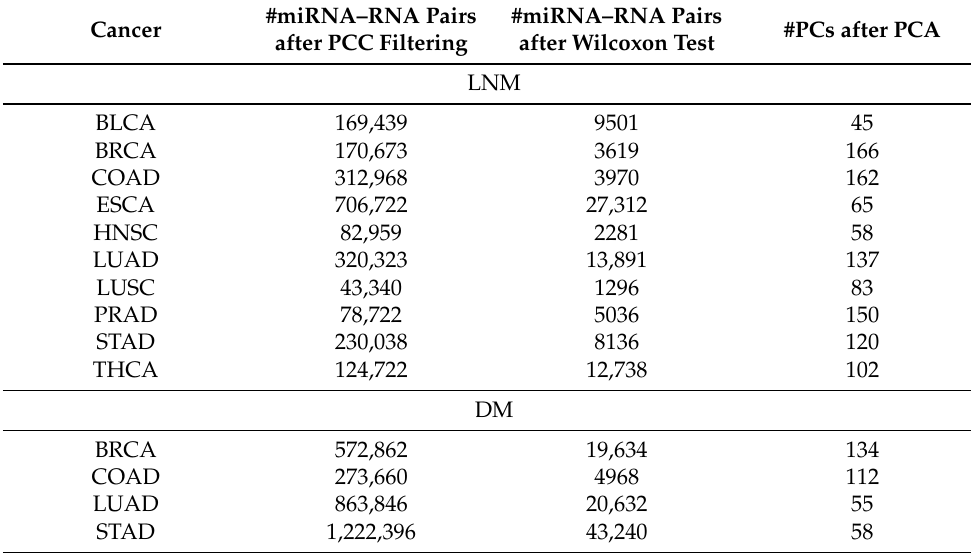
Table 3. The number of features after each filtering process.